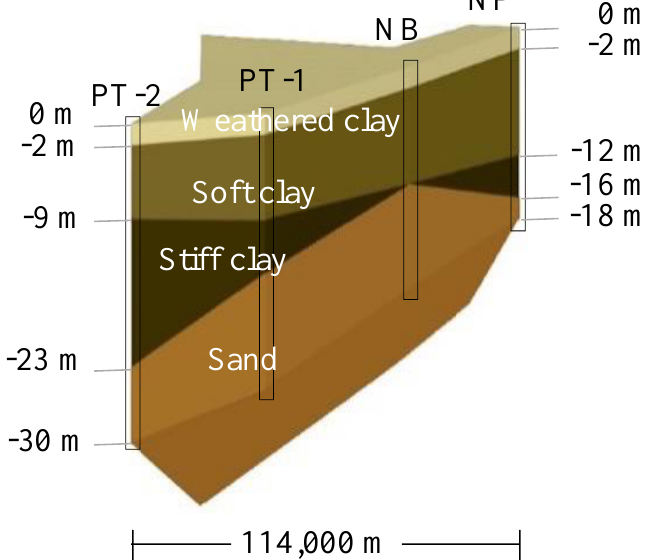
Figure 7. A 3D schematic of View B.